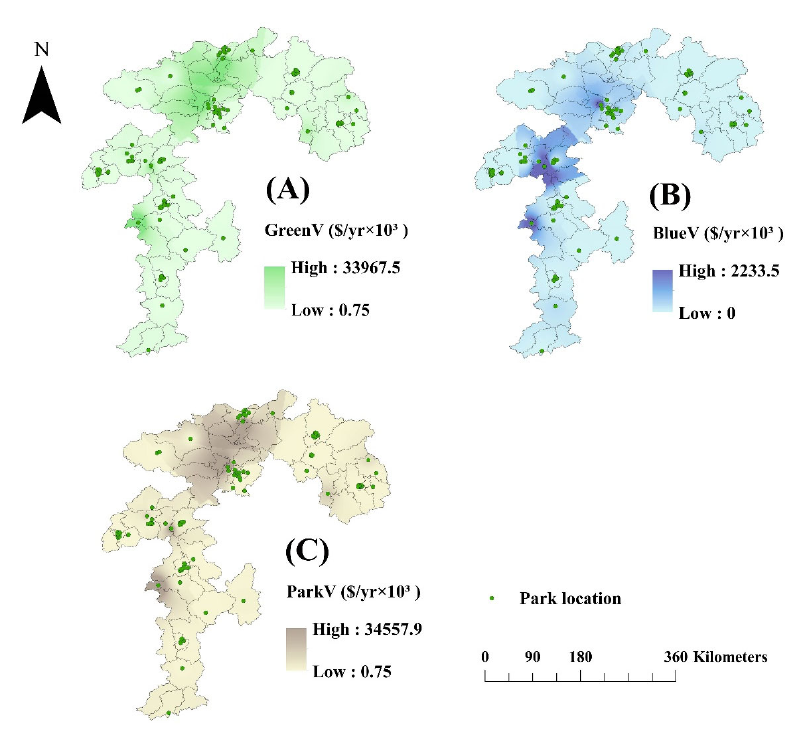
Figure 3. Spatial distributions of cultural ecosystem services’ values for urban green spaces (GreenV) ( A ), urban blue spaces (BlueV) ( B ), and UWPs (ParkV) ( C ) in Jiangxi.